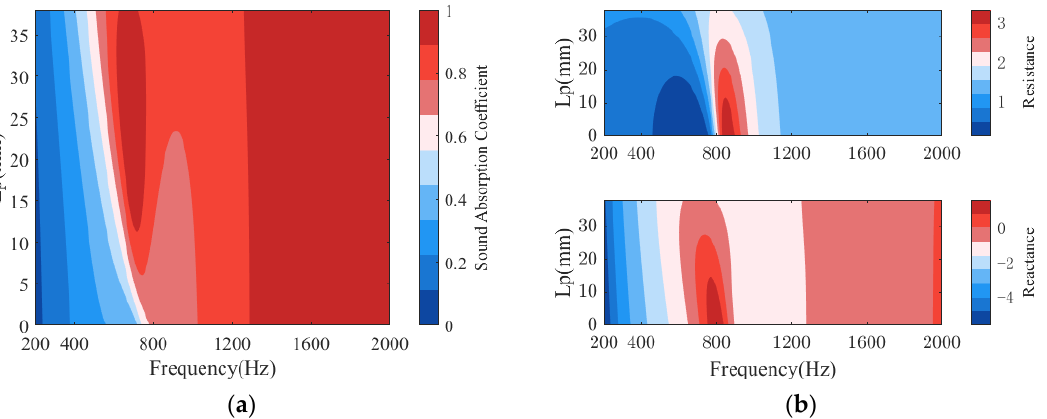
Figure 9. Effects of the area occupancy ratio A PR of PR on the sound absorption of PPCS: ( a ) sound absorption coefficients; ( b ) normalized surface acoustic impedance. Figure 10. Effects of the porous-material thickness Lp in the cavity of PR on the sound absorption of PPCS: ( a ) sound absorption coefficients; ( b ) normalized surface acoustic impedance.